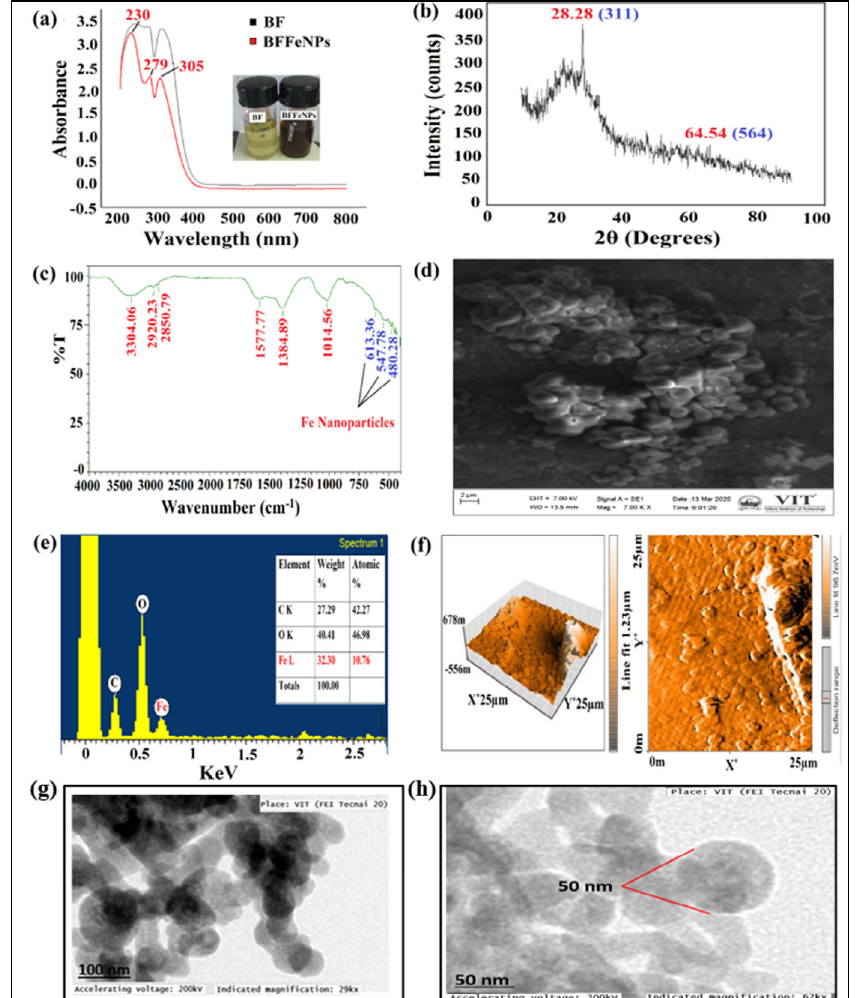
Fig. 2. Characterization of bioflocculant mediated iron nanoparticles ( BFFeNPs). (a) UV–visible spectrophotometry analysis of pure okra bioflocculant (BF) and synthesized Fe nanoparticles (BFFeNPs), (b) XRD analysis of synthesized Fe nanoparticles, (c) FTIR anal- ysis of synthesized Fe nanoparticle, (d) SEM images of the synthesized Fe nanoparticles, (e) EDAX analysis of synthesized Fe nanopar- ticles and (f) AFM image of synthesized Fe nanoparticles, (g) and (h) TEM micrograph of synthesized